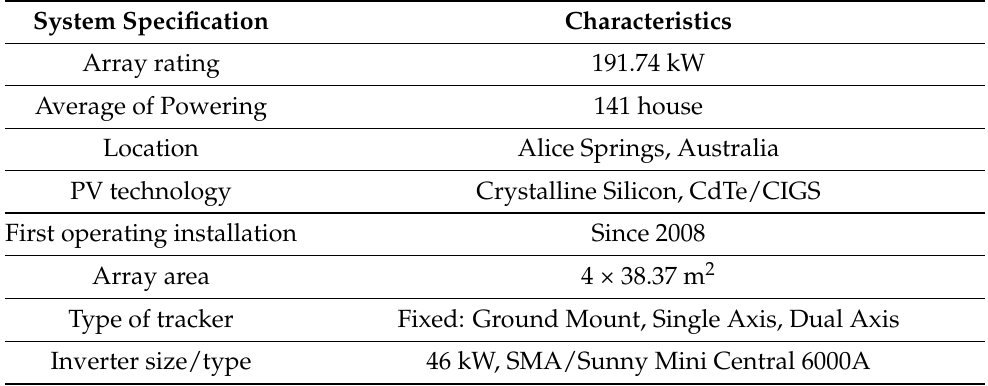
Table 2. The related characteristics of the PV